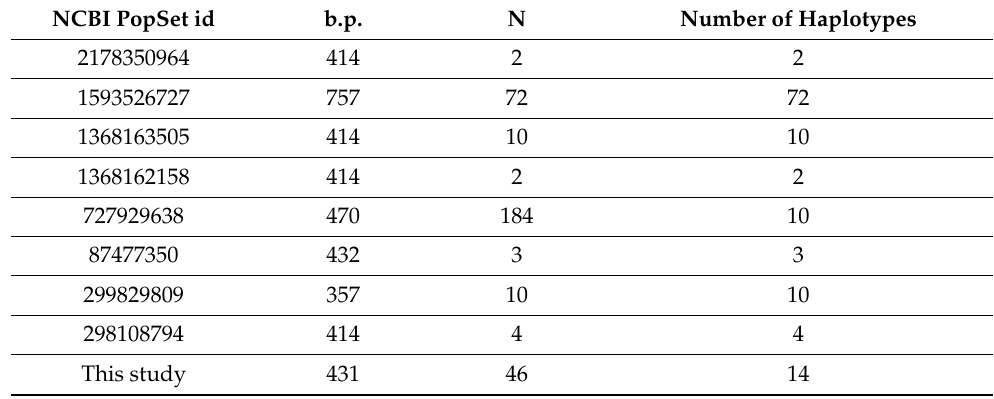
Figure 1. Phylogenetic tree of mtDNA tRNAleu-COII locus of 46 A. cerana samples. Vn—Vietnam samples, SK—South Korea samples, FE—Far East samples. Table 1. Apis cerana tRNAleu-COII sequences from the NCBI and this